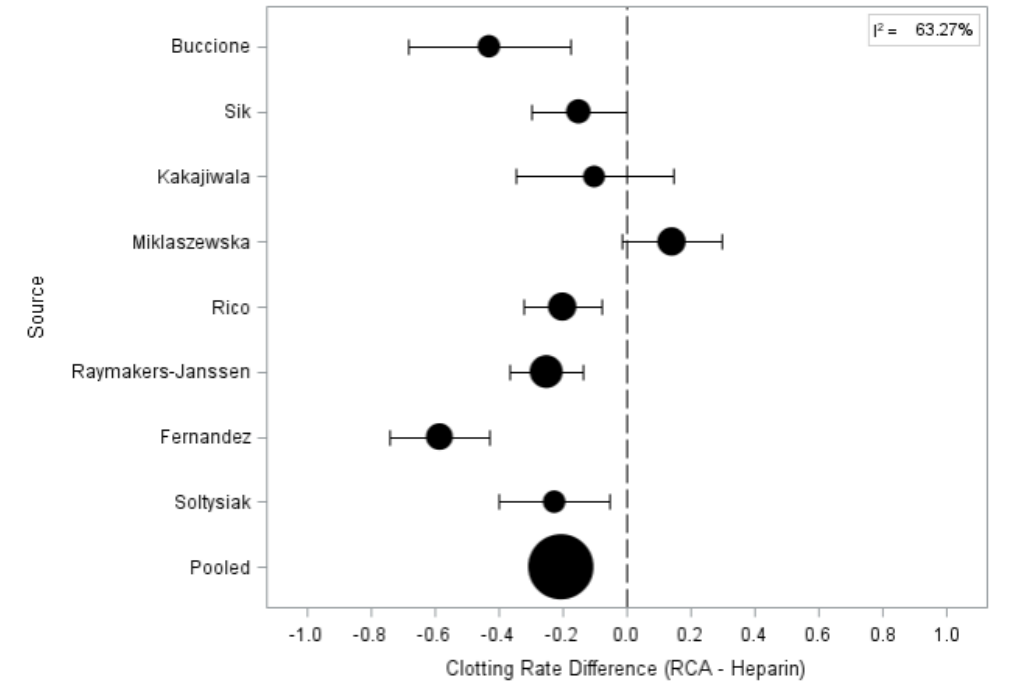
Figure 2. Forest plot for clotting rate difference between regional citrate anticoagulation vs. heparin anticoagulation.